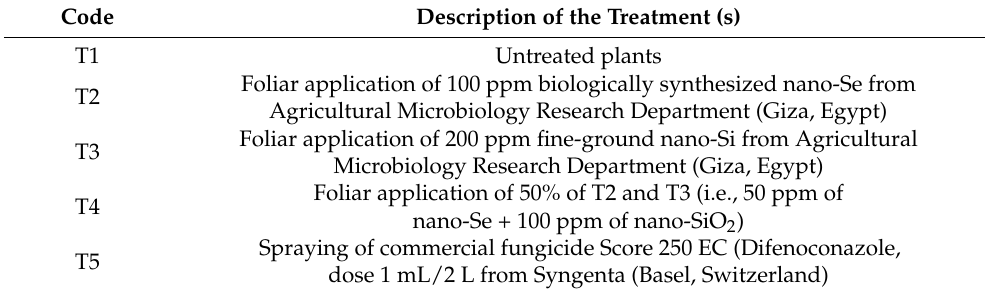
30 days after sowing and repeated with 10 days intervals between each spraying (treated 30, 40, 50, and 60 days after sowing). Code Description of the Treatment (s) T1 Untreated plants Foliar application of 100 ppm biologically synthesized nano-Se from T2 Agricultural Microbiology Research Department (Giza, Egypt) Foliar application of 200 ppm fine-ground nano-Si from Agricultural T3 Microbiology Research Department (Giza, Egypt) Foliar application of 50% of T2 and T3 (i.e., 50 ppm of T4 nano-Se + 100 ppm of nano-SiO 2 ) Spraying of commercial fungicide Score 250 EC (Difenoconazole, T5 dose 1 mL/2 L from Syngenta (Basel,